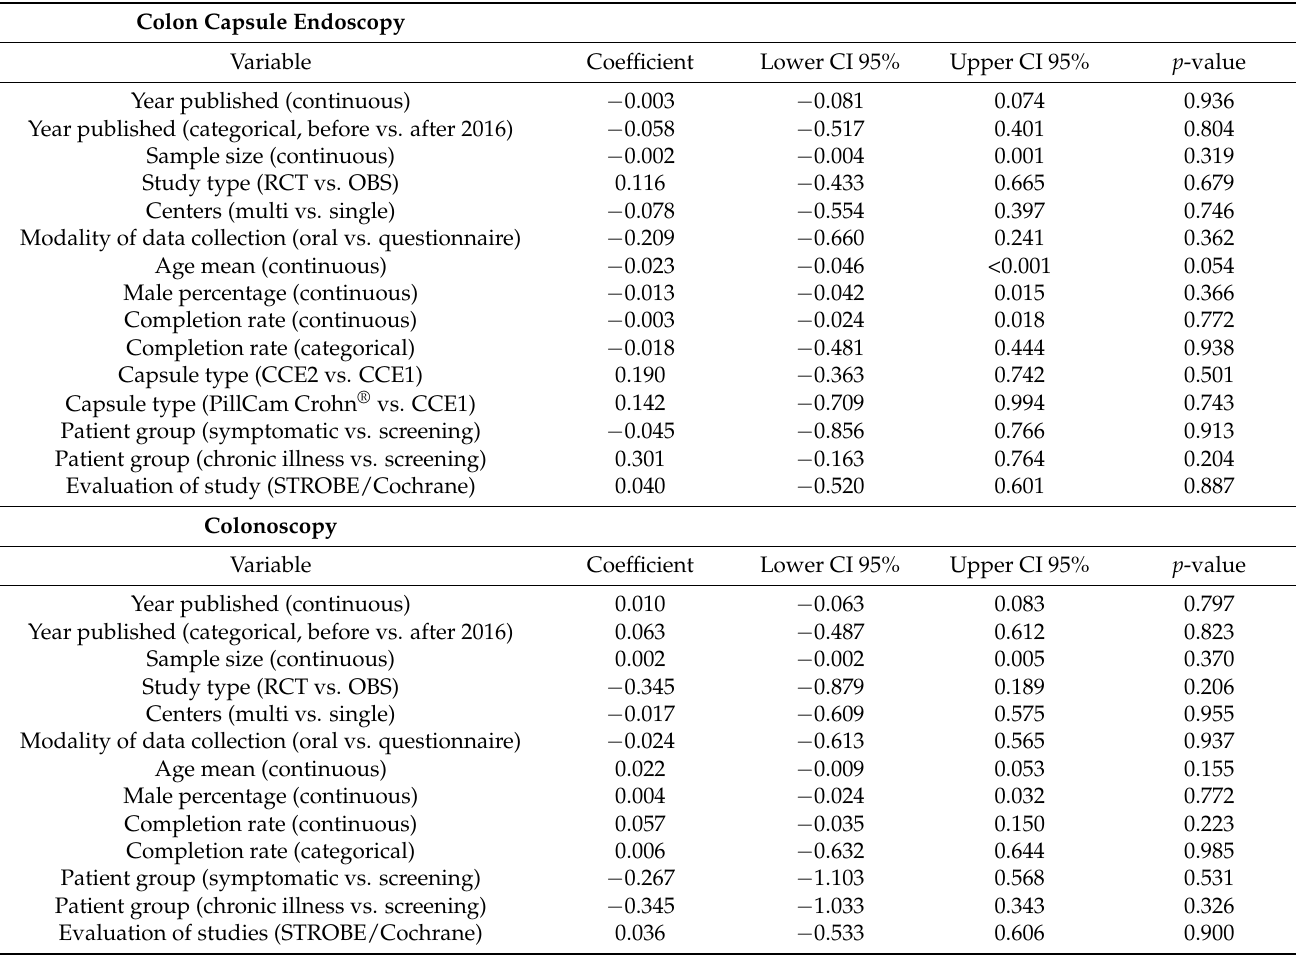
Table 2. Univariate